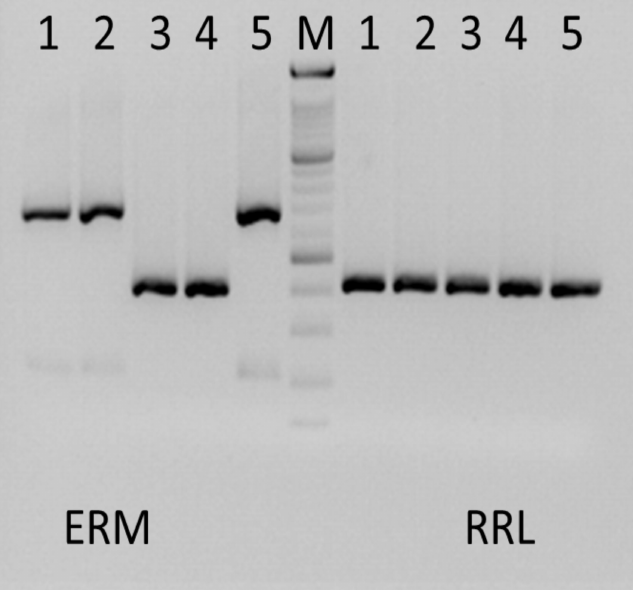
Figure 1. Analysis of the molecular size of the rrl and erm (41) gene products. The rrl and erm (41) gene products from isolated bacterial strains were PCR amplified for sequencing, and the size of the product was analysed in the gel. Products of the rrl gene (right) show in all isolates (1–5) a unified size of 420 bp. Products of the erm (41) gene (left) show full-length size of 673 bp in Str 1, Str 2, and Str 5, while truncated products of 397 bp were detected in Str 3 and Str 4. Molecular weight marker (M) is shown in the centre (100 bp ladder). Positive and negative controls are not